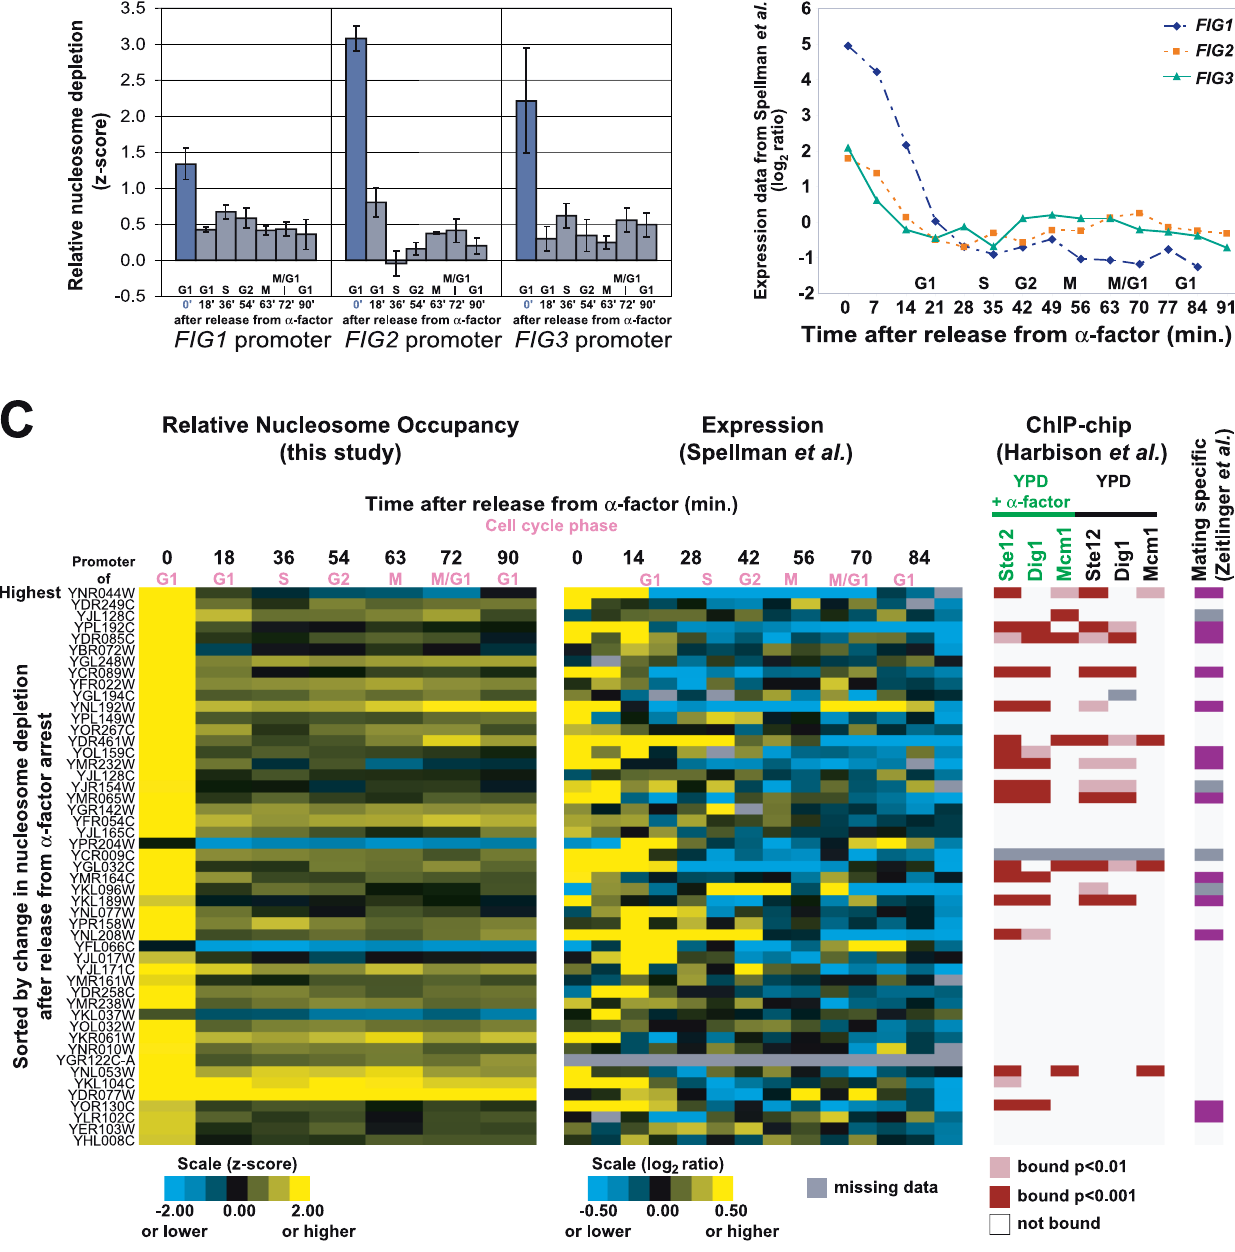
Figure 5. Release from Mating Pheromone Induces Increased Nucleosome Occupancy at FIG1, FIG2, and FIG3 Promoters (A) Relative nucleosome depletion at the FIG1, FIG2, and FIG3 promoters upon release from mating pheromone. Plotted values are z -scores derived from FAIRE data. At 0 min, cells are in a -factor–induced arrest. Error bars are 6 SEM. (B) Previously obtained expression data for FIG1, FIG2, and FIG3 after release from a -factor [30]. (C) Promoters exhibiting a large increase in nucleosome occupancy after release from a -factor are shown (FAIRE z -score decrease greater than 1), with corresponding gene expression data [30] and ChIP-chip data [40]. In the far-right column, a purple box indicates that a downstream gene was characterized as mating specific by Zeitlinger et al.